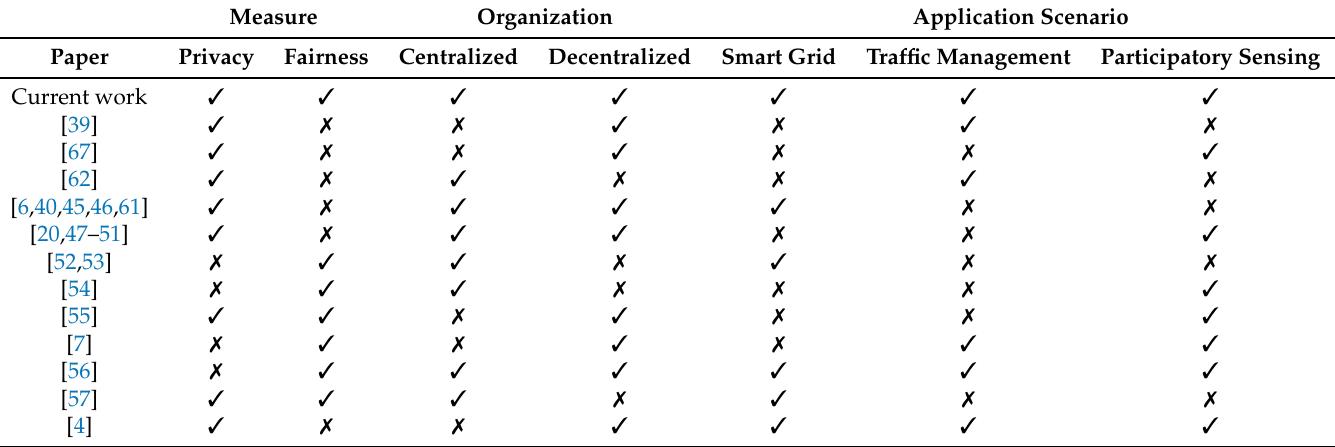
Table 6. Comparison of related